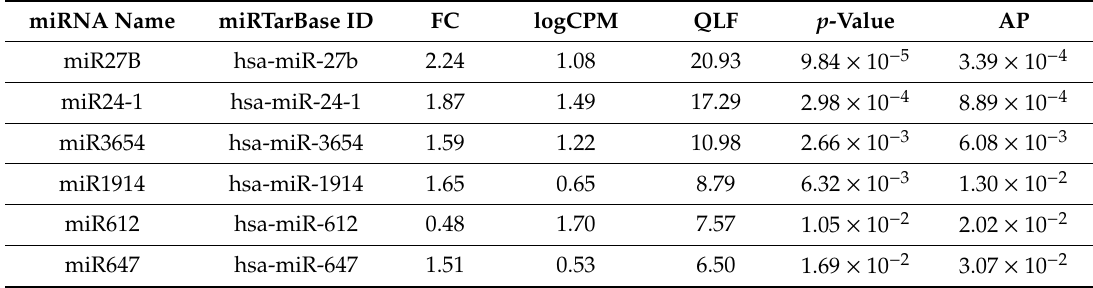
Table 1. Di ff erentially expressed miRNAs associated with warts as sorted by adjusted p -value